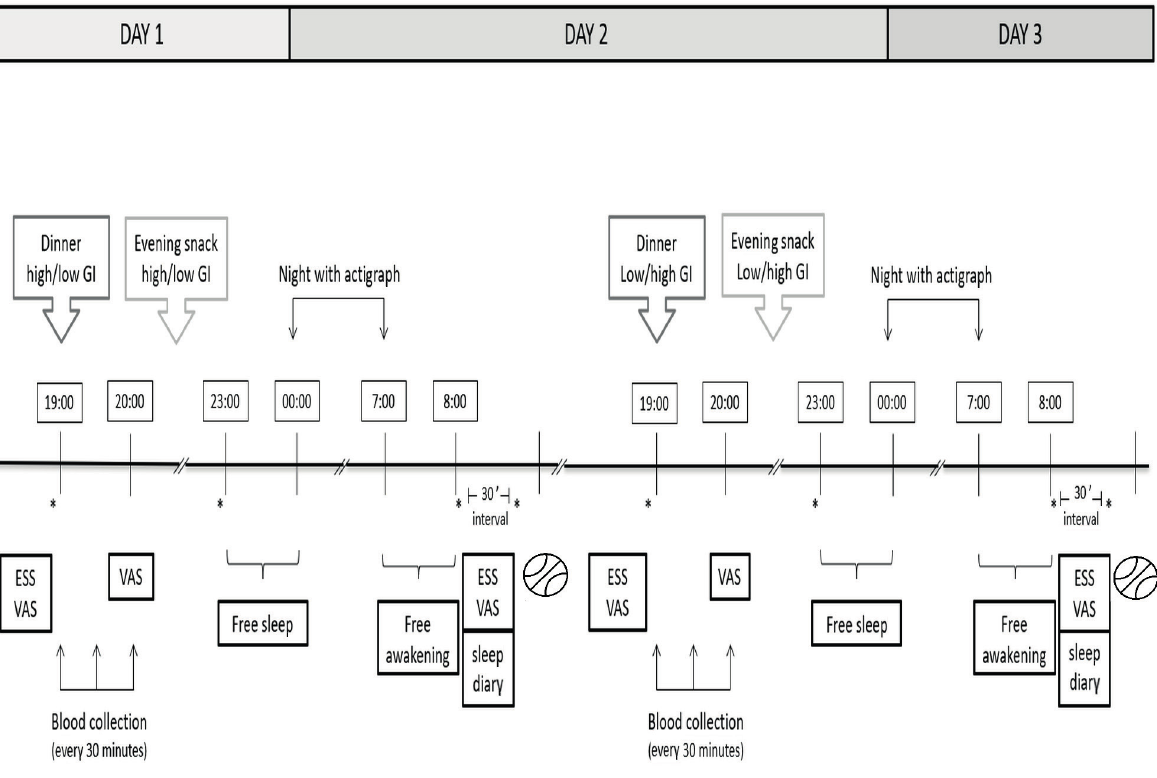
Figure 1 - Experimental study